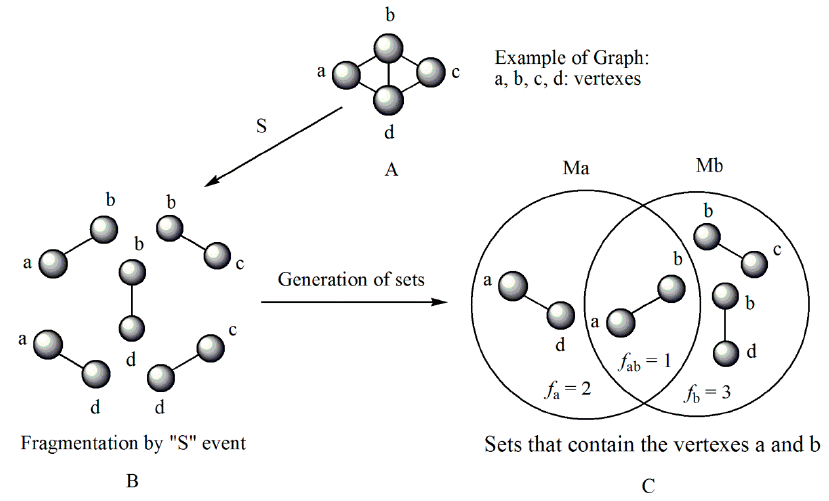
Figure 1. Example of graph G ( A ), fragmentation according to an event “S” ( B ) and the sub-graphs sets for vertexes a and b ( C ).